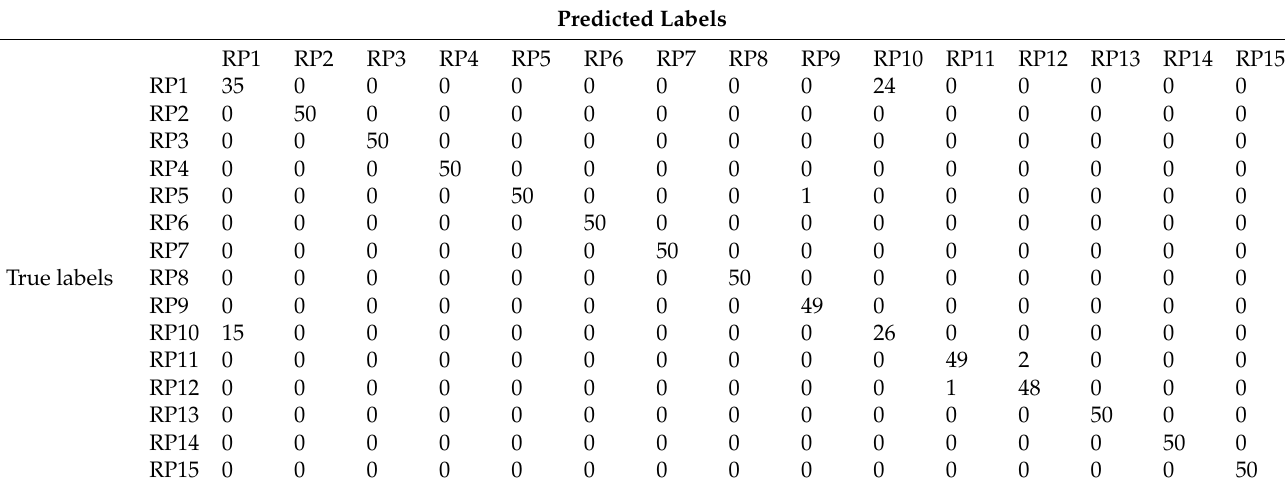
Table 9. Specific reference point confusion matrix of CWT without augmentation using CNN